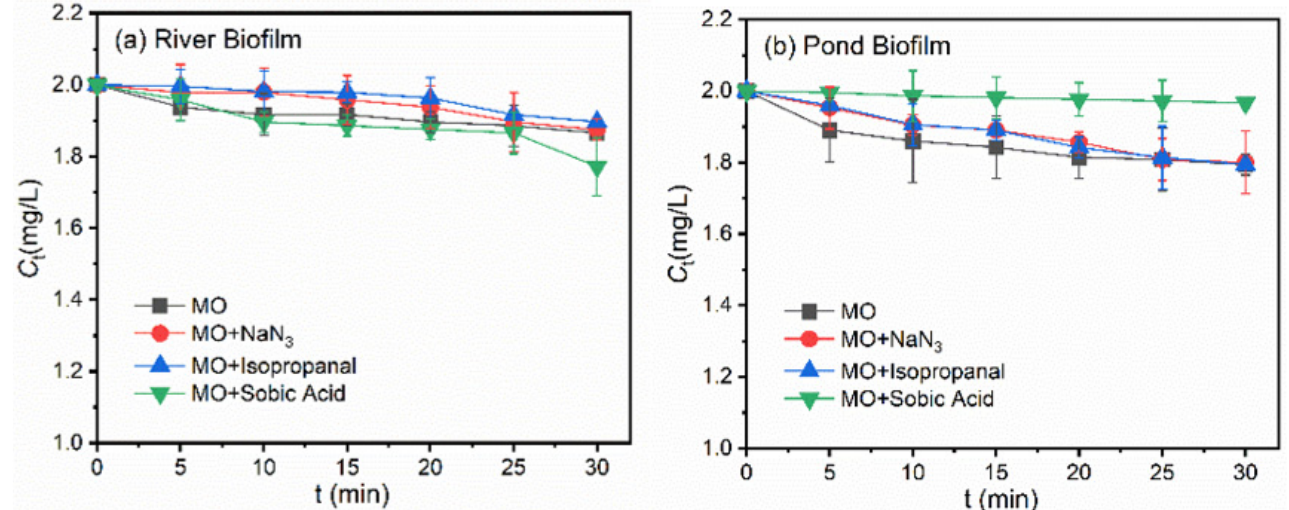
Figure 7. Photodegradation rate of MO with quenchers (isopropanol, NaN3 and sorbic acid) in the presence of the EPS derived from ( a ) River Biofilm and ( b ) Pond Biofilm. Experimental conditions: [MO] 0 = 2 mg/L, [EPS content] = 14 mgC/L, pH = 6.8 (10 mM phosphate buffer).